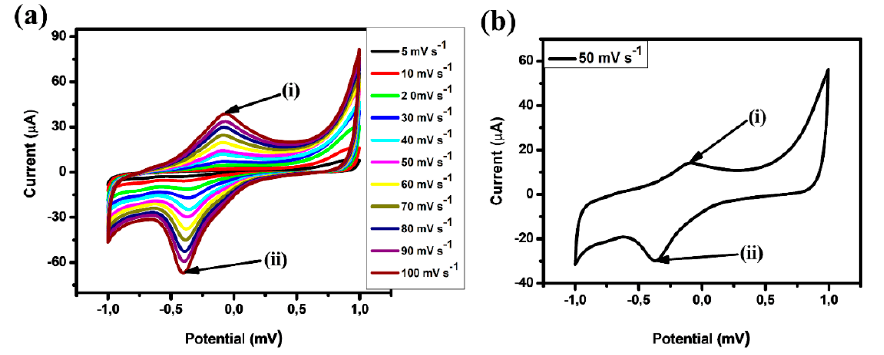
Figure 8. Cyclic voltammetry (CV) behaviour of ( a ) GO at 5–100 mV·s − 1 and ( b ) GO at 50 mV·s − 1 . The electrochemical behaviour of GO was studied in the potential range of − 1.0 V to +1.0 V in 0.1 M KOH.